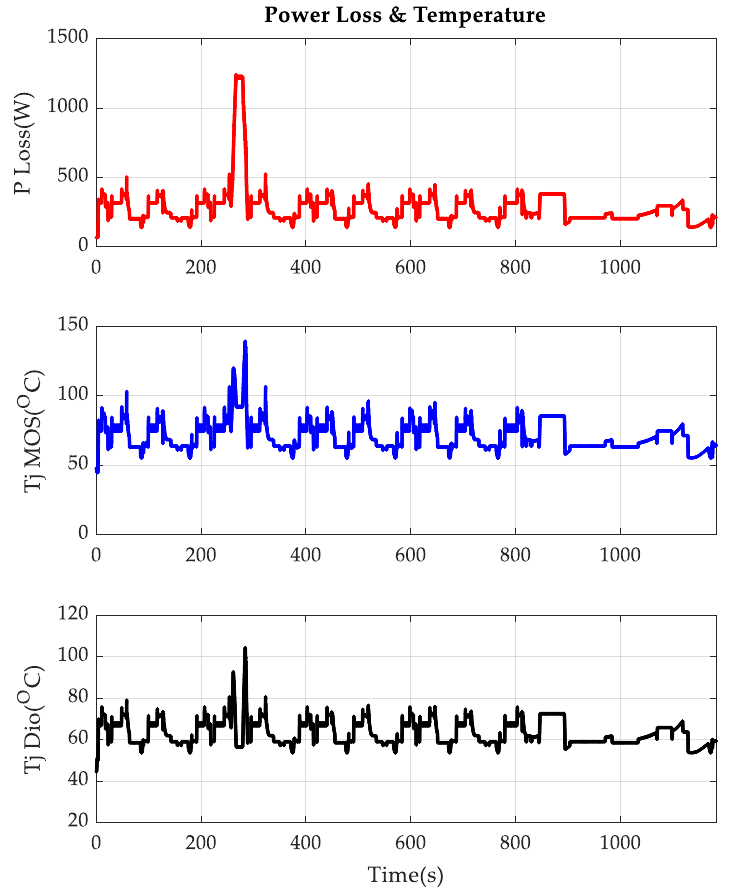
Figure 26. Power loss and junction temperature.